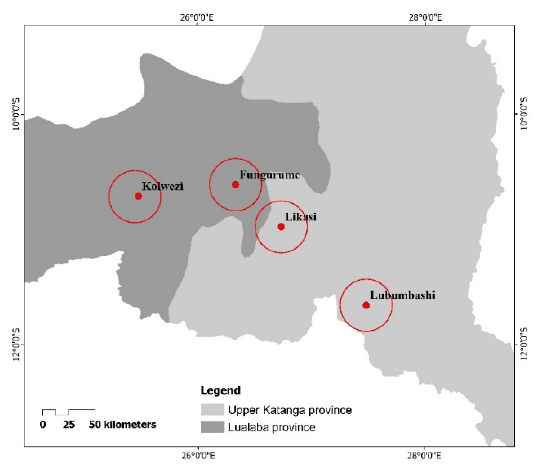
Figure 2. Measuring the anthropization of the landscape around the main agglomerations in South- eastern Katanga. The circle around the 4 poles of anthropization corresponds to the part of the territory studied and is referred to in this study as the “zone”.